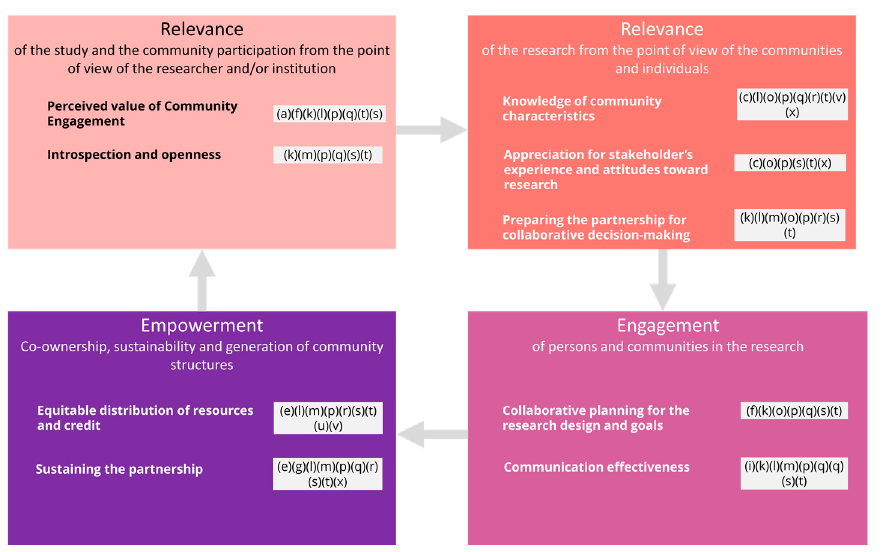
Figure 2. Results discussed in light of the CEDI model.